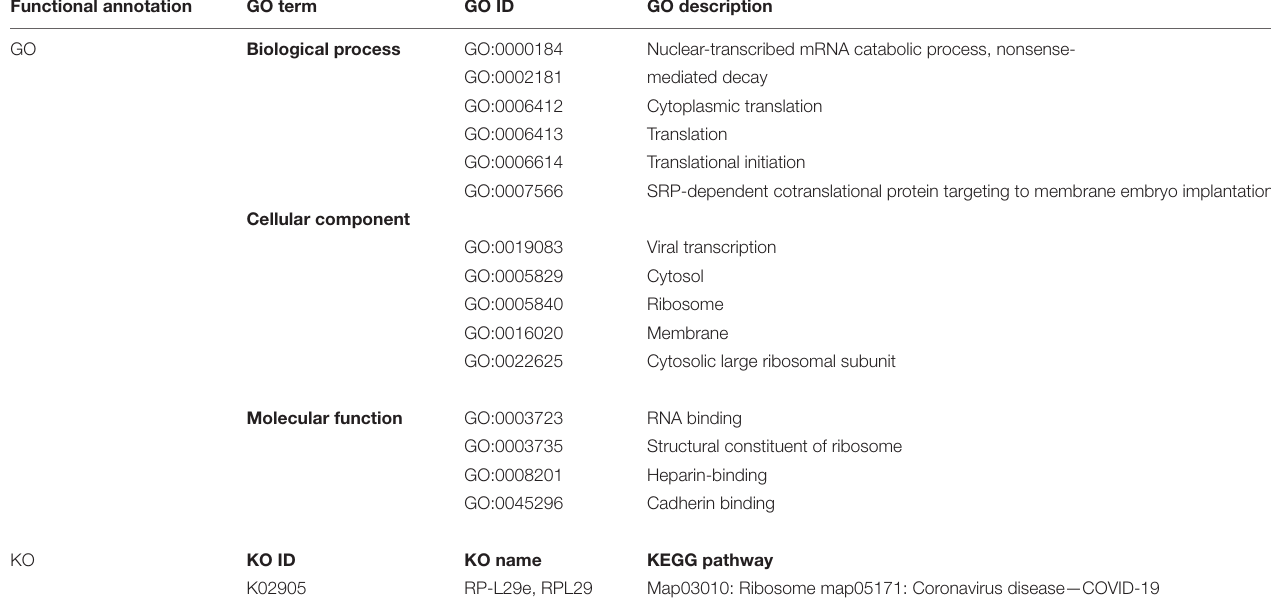
TABLE 2 | Functional Enrichment analysis of highly expressed RPL29 protein deciphering the GO terms and KEGG pathways. Functional